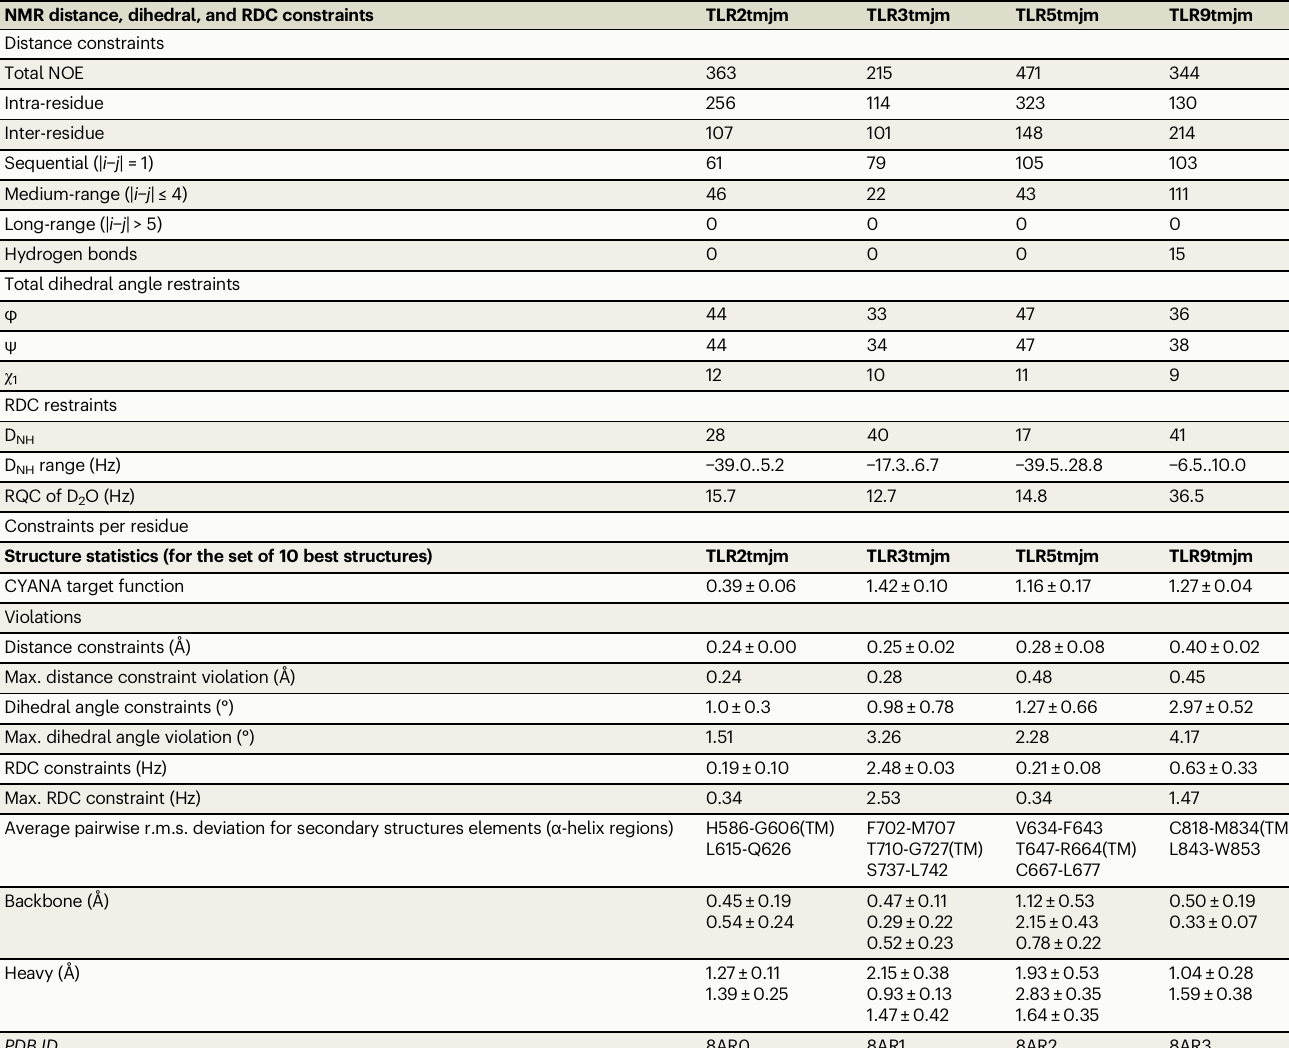
Table 1 | Statistics of NMR input data and parameters of the obtained spatial structures NMR distance, dihedral, and RDC